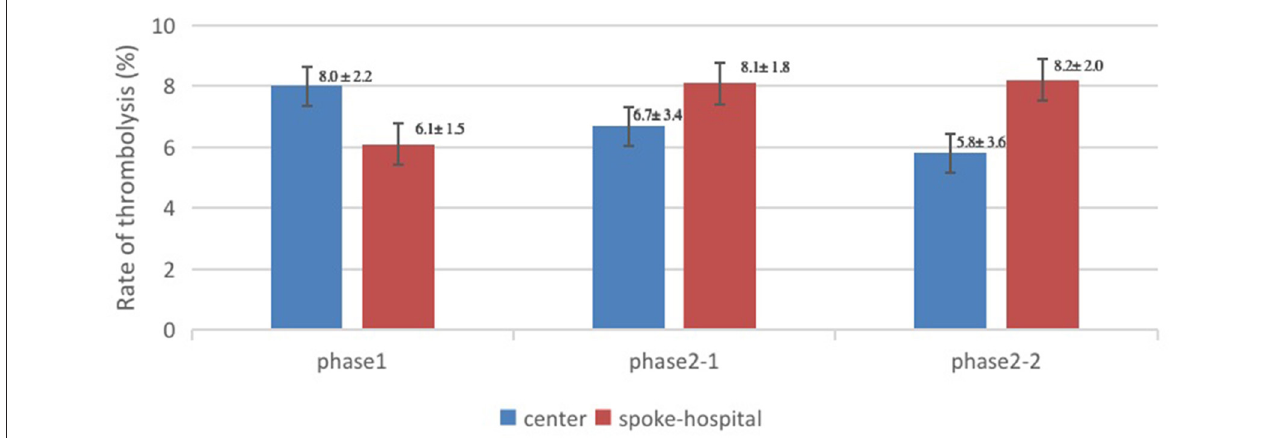
FIGURE 2 | Comparisons of the thrombolysis rate between the hub center and spoke hospitals. Phase 1, pre-telestroke phase (January–December 2019); phase 2-1, post-telestroke phase during coronavirus disease 2019 (COVID-19) pandemic in China (January–June 2020); phase 2-2, post-telestroke phase, COVID-19 epidemic better controlled in China (July–December